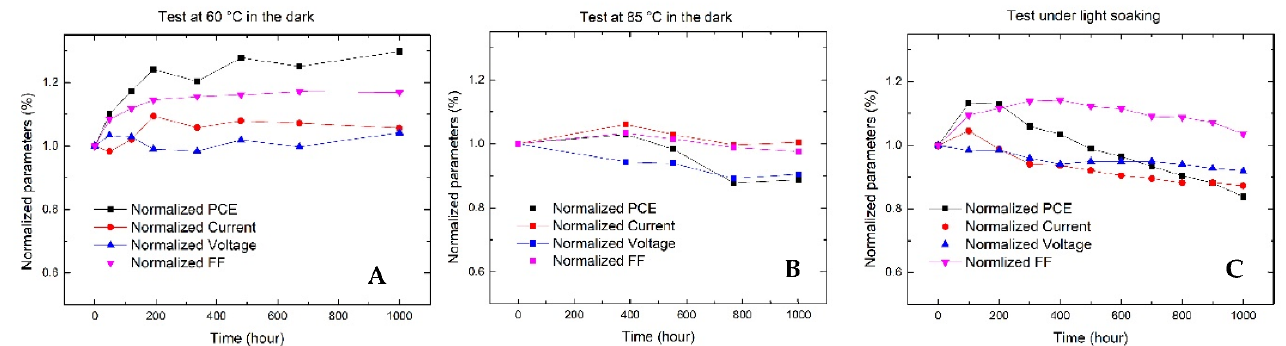
Figure 9. Trend of all electrical parameters during the 1000 h test ( A ) at 60 °C, ( B ) at 85 °C and ( C ) under light soaking.